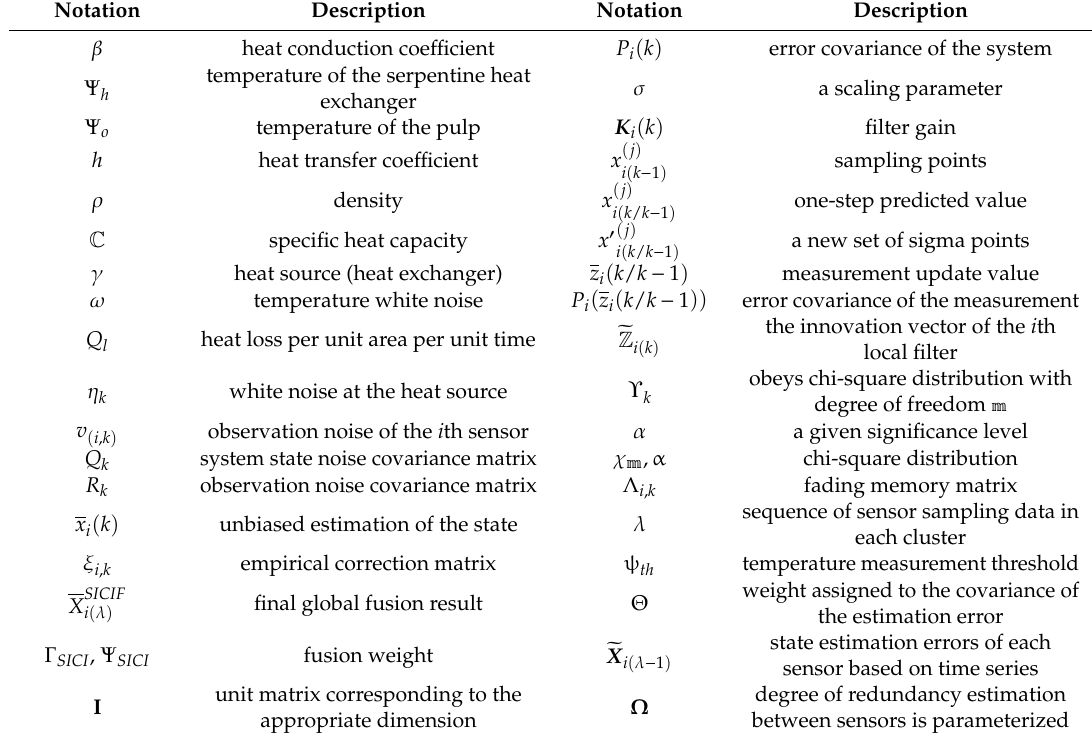
Table 1. Notation used in this study.